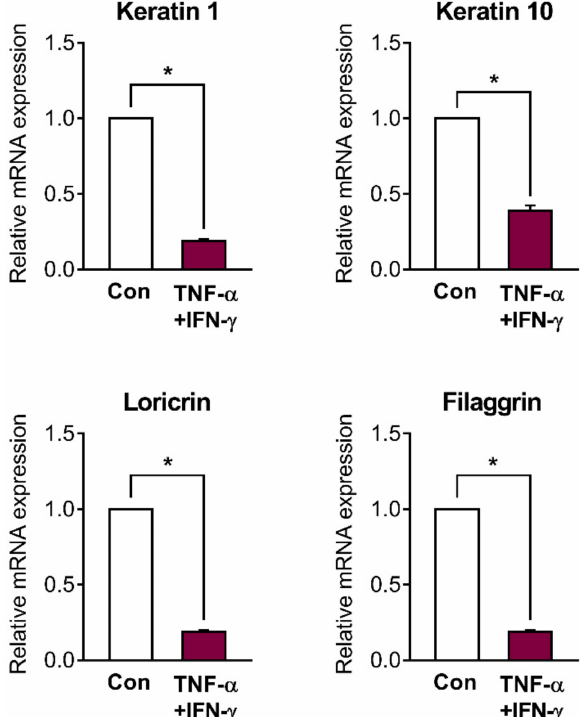
Figure 2. Skin barrier genes are downregulated in inflamed HaCaT cells. The cells were stimulated with or without tumor necrosis factor (TNF)- α /interferon (IFN)- γ (10 ng/mL each) for 48 h. Then, the cells were harvested and the relative mRNA expression of skin barrier genes ( keratin 1 , keratin 10 , loricrin, and filaggrin ) was measured. Results are shown as mean ± SEM of three experiments. * p < 0.05, between the